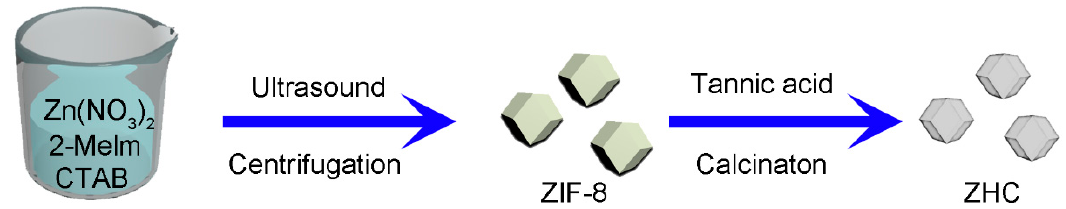
Figure 1. Schematic illustration of the fabrication process of ZIF-8 (zeolitic imidazolate framework)- derived hollow carbon